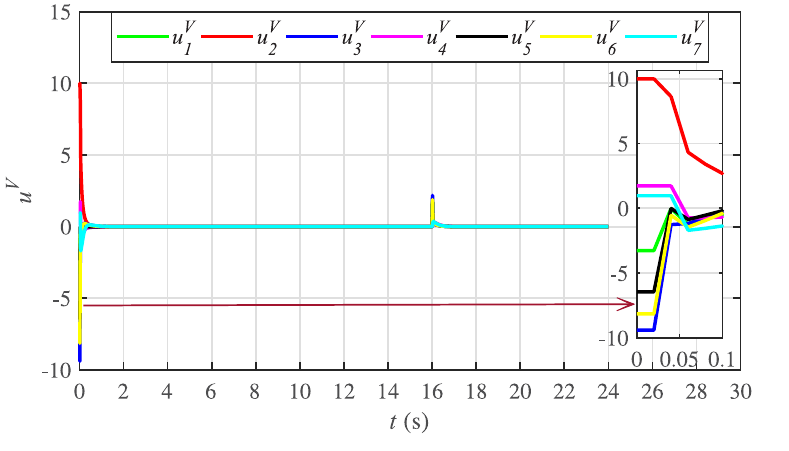
Fig 15. Voltage regulation control efforts under case